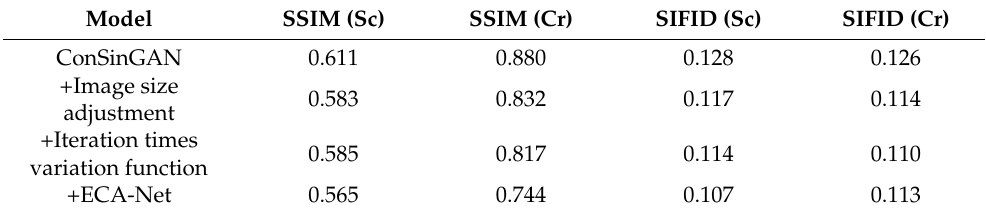
Table 5. Comparison of SSIM and SIFID values in ablation experiments.